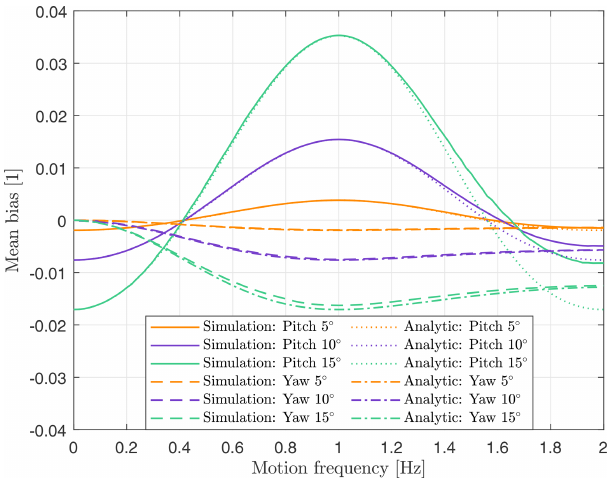
Figure 6. Mean bias caused by pitch (solid) and yaw (dashed) mo- tion as a function of oscillation frequency f p for three arbitrary am- plitudes of motion A = 5, 10, and 15 ◦ in the absence of wind